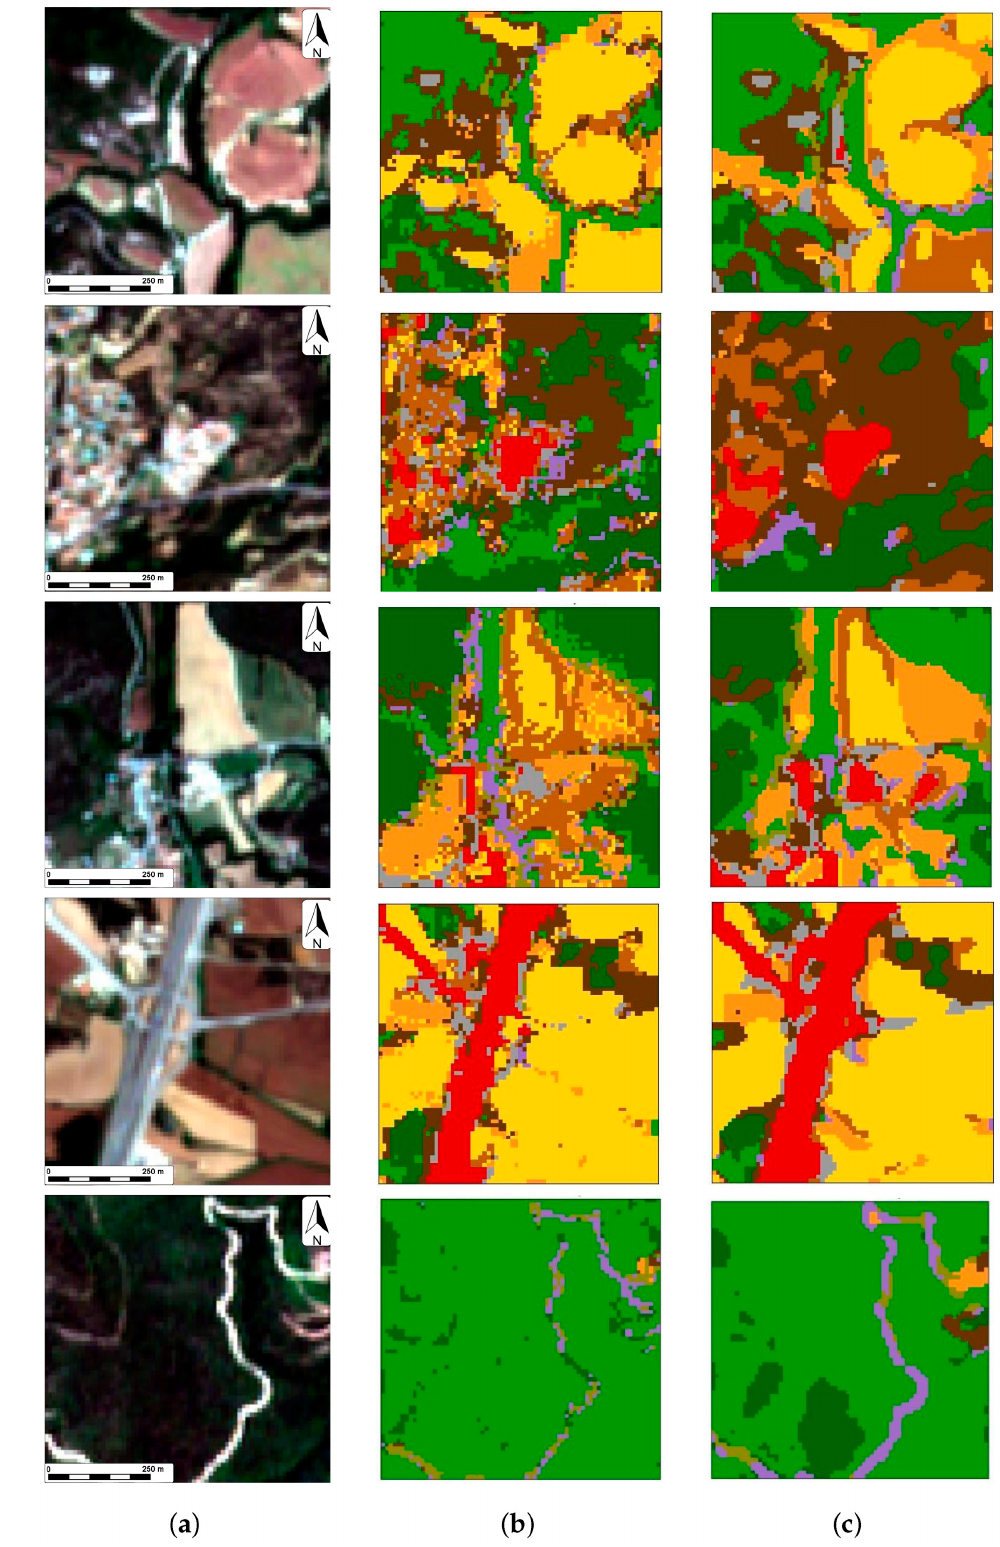
Figure 11. Illustration of the noise present in ground truth annotations on small 70 × 70 patches: ( a ) input image, ( b ) ground truth segmentation map, ( c ) semantic segmentation results (SSSR branch, model v 4 using Pixel